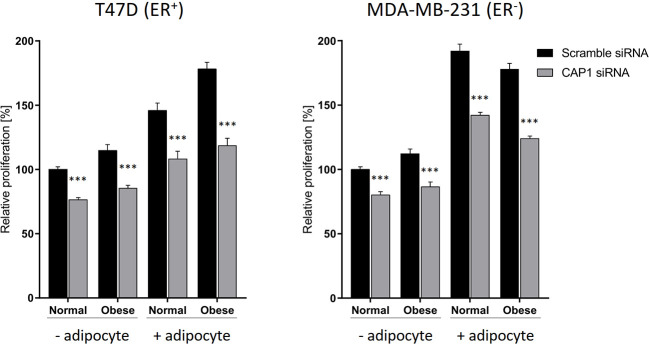
Effect of CAP1 silencing on breast cancer cell proliferation in the presence or absence of adipocyte secretome stimulation under normal and obese-like metabolic conditions in ER-positive T47D cells and ER-negative MDA-MB-231 cells. Three days after CAP1 knockdown, CAP1 silenced or control cells were re-seeded for proliferation experiments, after 24 h the medium was changed to adipocyte secretome or control medium, and proliferation assessed following 72 h exposure. Graphs show mean ± SEM from four to five independent experiments with statistical comparisons between groups by two-way ANOVA and Sidak’s post-hoc test. ***P < 0.001.